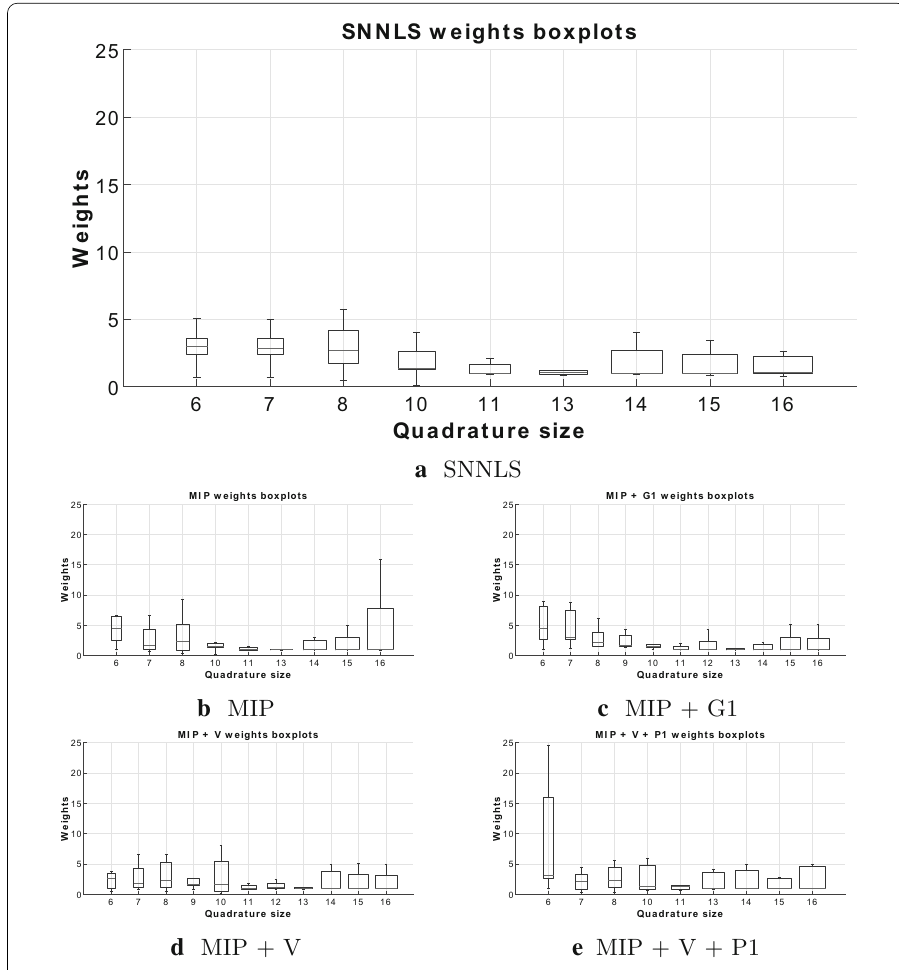
Fig. 9 Hyper-reduction weights boxplots for consistency constraints formulations in comparison with the SNNLS and MIP methods